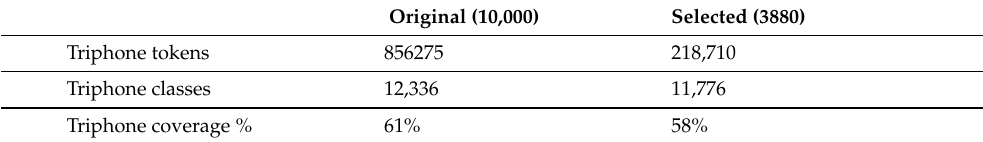
Table 8. Comparison of triphone coverage at different stages in the selection process.